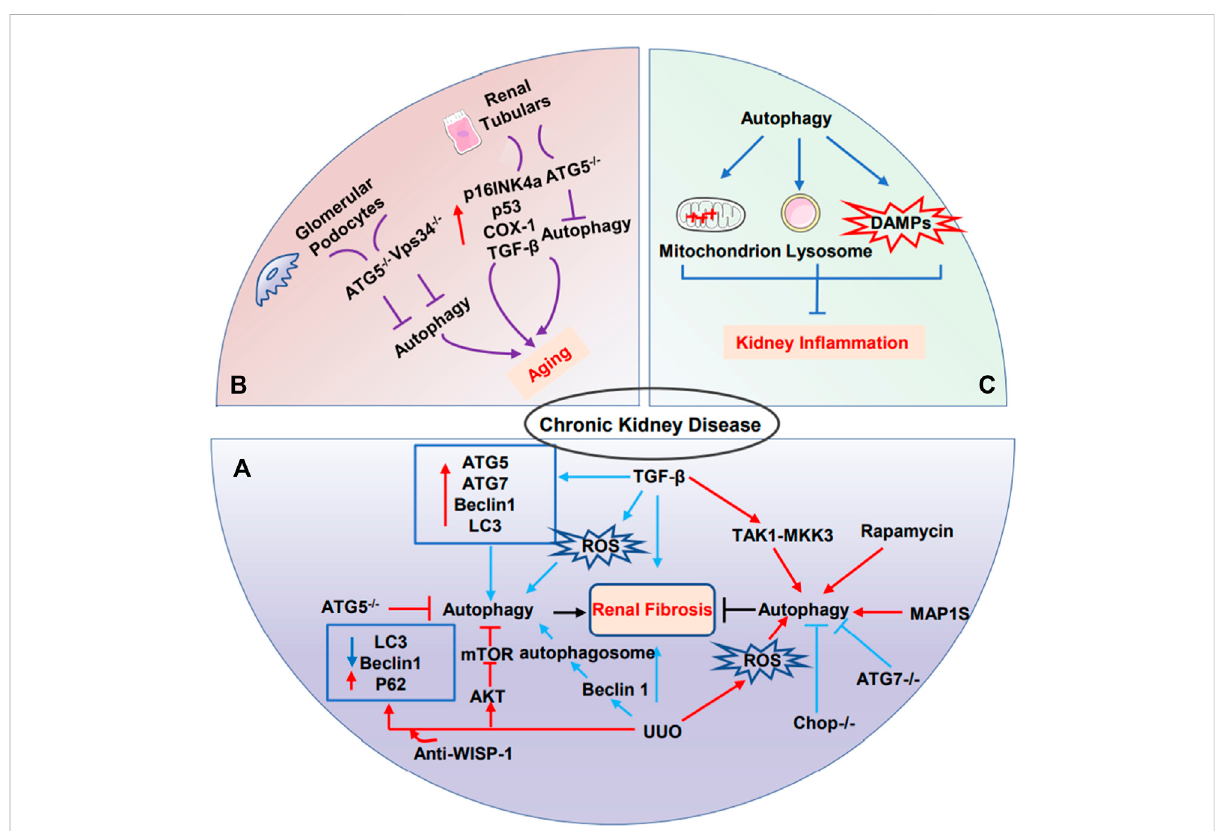
FIGURE 3 The role of autophagy in CKD. (A) The dual role of autophagy in renal fi brosis. (B) Glomerular podocytes and renal tubular cells are frequently implicated in renal senescence. Podocyte-speci fi c ATG5 knockout mice or Vps34 knockout mice may lead to kidney aging. Renal tubulars-speci fi c ATG5 knockout mice led to kidney aging. (C) Autophagy suppresses excessive in fl ammation through the clearance of damaged-mitochondrion, damaged-lysosome, and damaged-associated-molecular patterns to protect